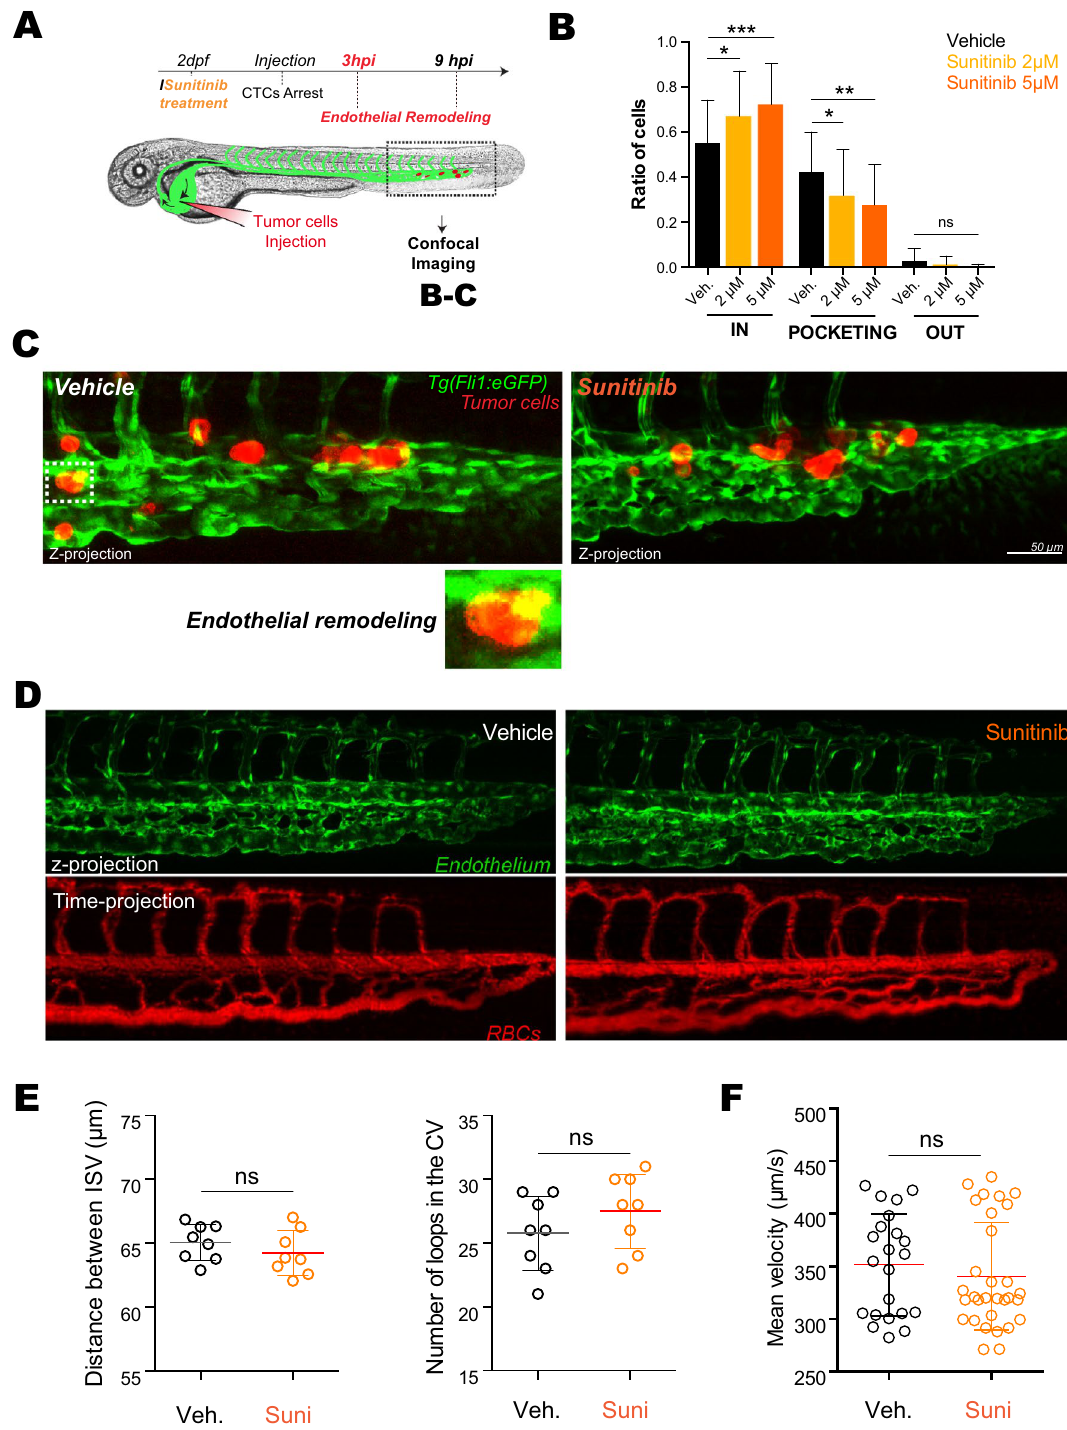
Figure 3. Inhibition of VEGFRs with sunitinib reduces endothelial remodeling in zebrafish embryos. (A) Experimental setup used: zebrafish are imaged at 3 hpi (hours post-injection). ( B) Quantification of intravascular, remodeling and extravasated cells 3hpi. N cells: vehicle = 622, sunitinib 2 µM = 375, sunitinib 5 µM = 254. N embryos : vehicle = 62, sunitinib 2 µM = 34, sunitinib 5 µM = 27, Kruskal–Wallis test followed by Dunn’s multiple Comparison test. (C) Representative image of arrested D2A1 cells in the caudal plexus of vehicle or sunitinib treated embryos. Vehicle: DMSO. ( D) Representative confocal image of the caudal plexus architecture (upper panel) and blood flow (lower panel, RBC = red blood cells) 3 h post-treatment with sunitinib vs vehicle in Tg(fli1a:EGFP;gata1:DsRed) . ( E) Quantification of the effect of sunitinib on vessel architecture after 3 h of treatment with vehicle or 5 µM of sunitinib, N = 8, Student t test. ( F ) Blood flow perfusion profiles of the same embryos (from D ) and quantification of the blood flow velocity in the caudal plexus of embryos in both conditions after 3 h of treatment with vehicle or 5 µM of sunitinib. N embryos: vehicle = 8, sunitinib 5 µM = 10. Mann Whitney